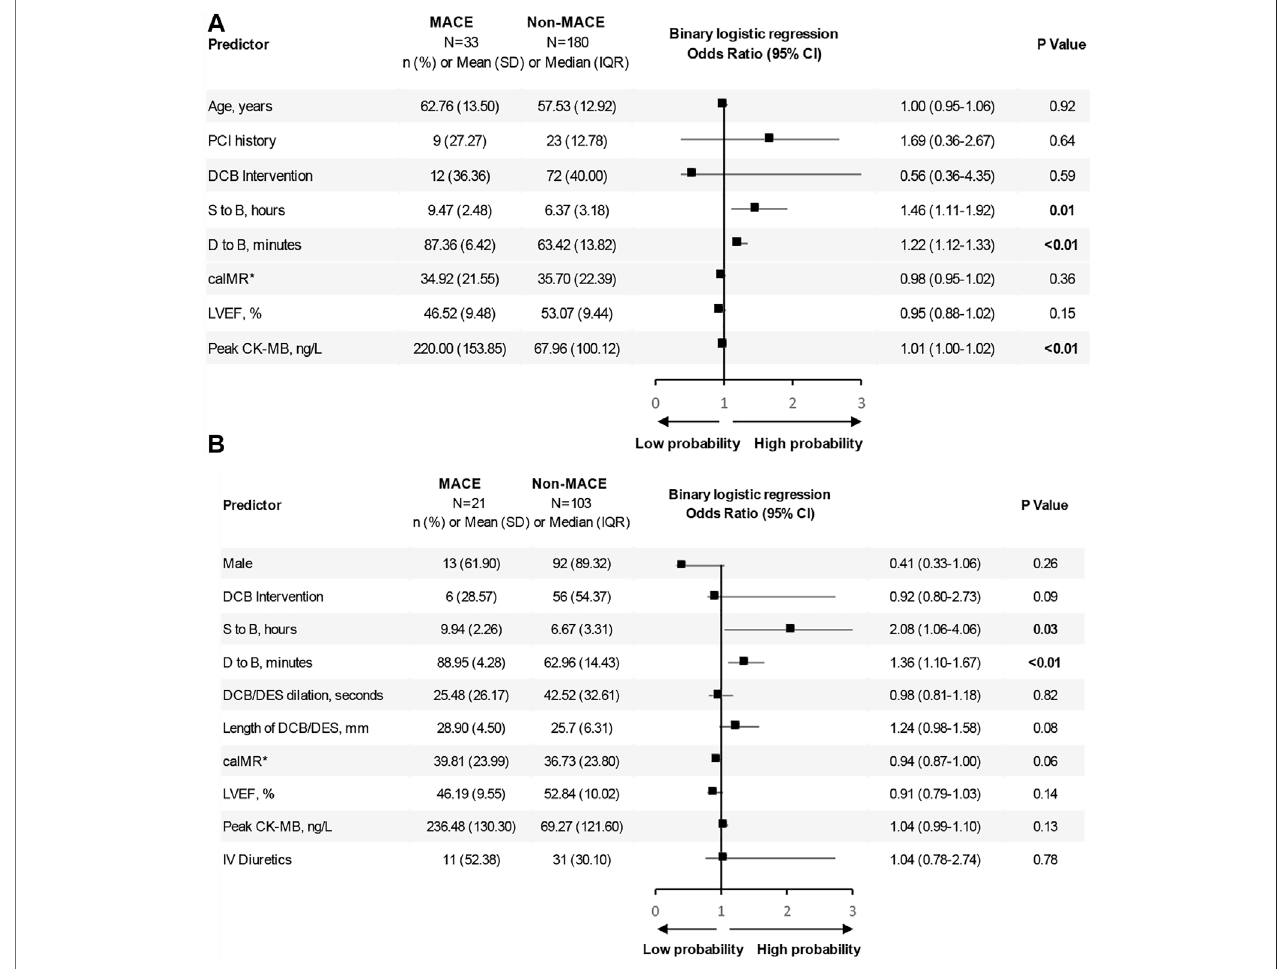
FIGURE 4 | Binary logistic regression analysis. Shown are odds ratios for MACEs among patients. (A) Binary logistic regression analysis before propensity score matching. Shown are odds ratios for MACEs among patients before propensity score matching. The size of the square corresponds to the number of patients in two groups. (B) Binary logistic regression analysis after propensity score matching. Shown are odds ratios for MACEs among patients after propensity score matching. The size of the square corresponds to the number of patients in two groups. Abbreviations: MACE, major adverse cardiovascular events; PCI, percutaneous coronary intervention; DCB, drug-coated balloons; DES, drug-eluting stents; S to B, time from symptom to balloon; D to B, time from door to balloon; caIMR, coronary- angiography-derived index of microcirculatory resistance; LVEF, Left ventricular ejection fraction; CK-MB, MB isoenzyme of creatine kinase; IV diuretics, Intravenous diuretics; SD, standard deviation; IQR, inter-quartile range; CI, con fi dence interval.